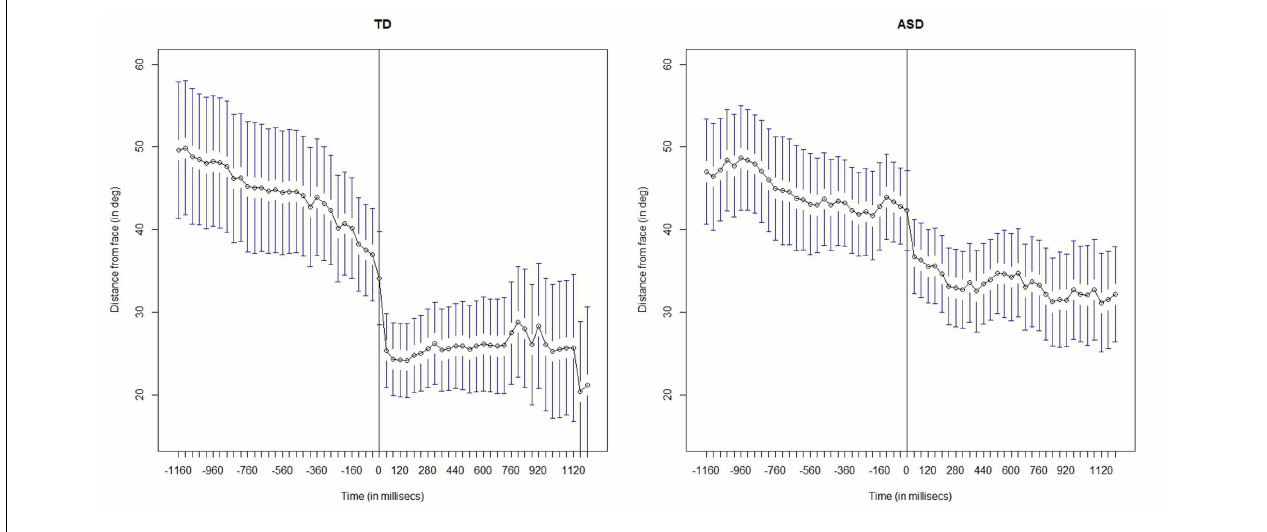
FIGURE 4 | Facial expression condition: frame-by-frame plot of the face-to-gaze distance, for the TD children (on the Left) and for the children with ASC (on the Right). Mean and quartiles of the temporal